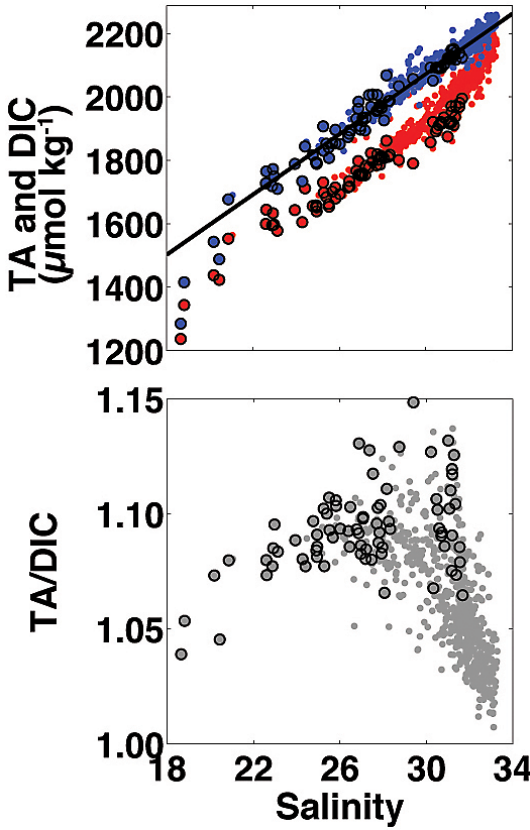
Fig. 2. May and September PWS measurements of TA (blue) and DIC (red) collected between 2009 and 2012 as a function of salinity (top; µmolkg − 1 ). A linear fit between TA and salinity is shown for data with salinity greater than 22 (TA=47.5 × Salinity+648; r 2 = 0 . 96). Lower panel shows TA/DIC ratio versus salinity. Surface data ( < 9m) are highlighted in each panel using bold circles.